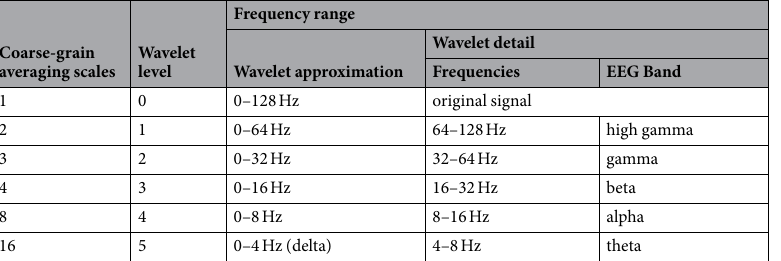
Table 4. The coarse-graining procedure is mathematically identical to the Haar wavelet transform. For signal collected with a sampling rate of 256 samples per second, the frequency bands contained in the scales, wavelet approximations, and wavelet details are